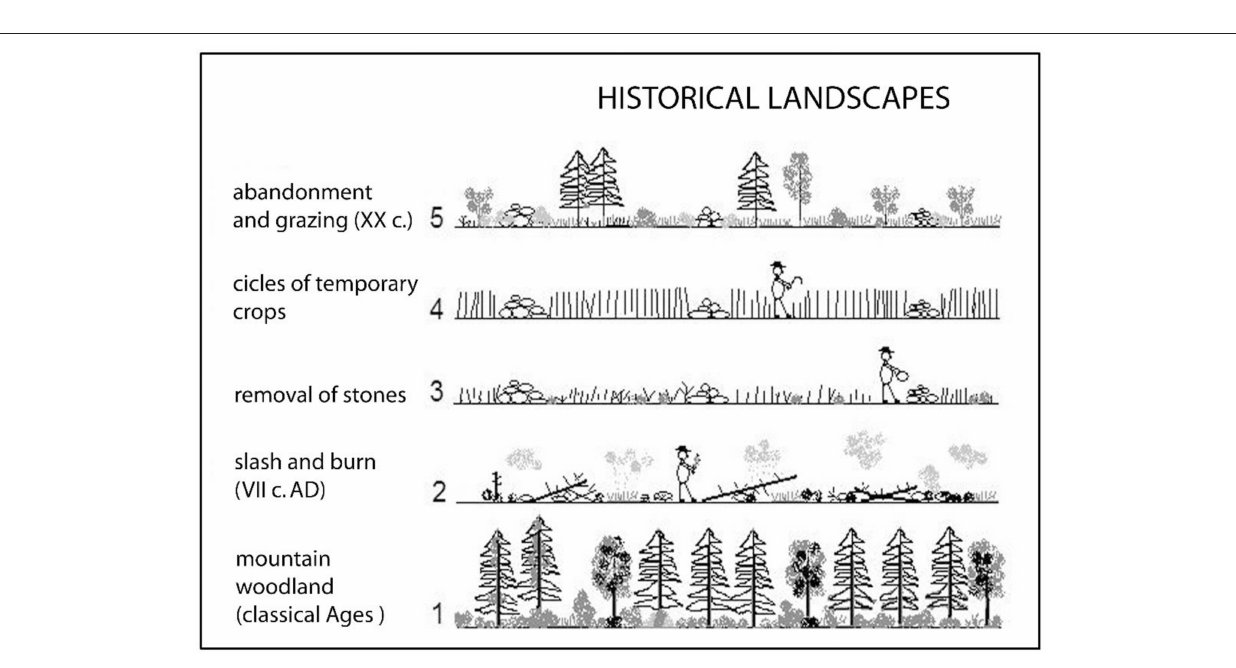
Frontiers in Environmental Science | www.frontiersin.org